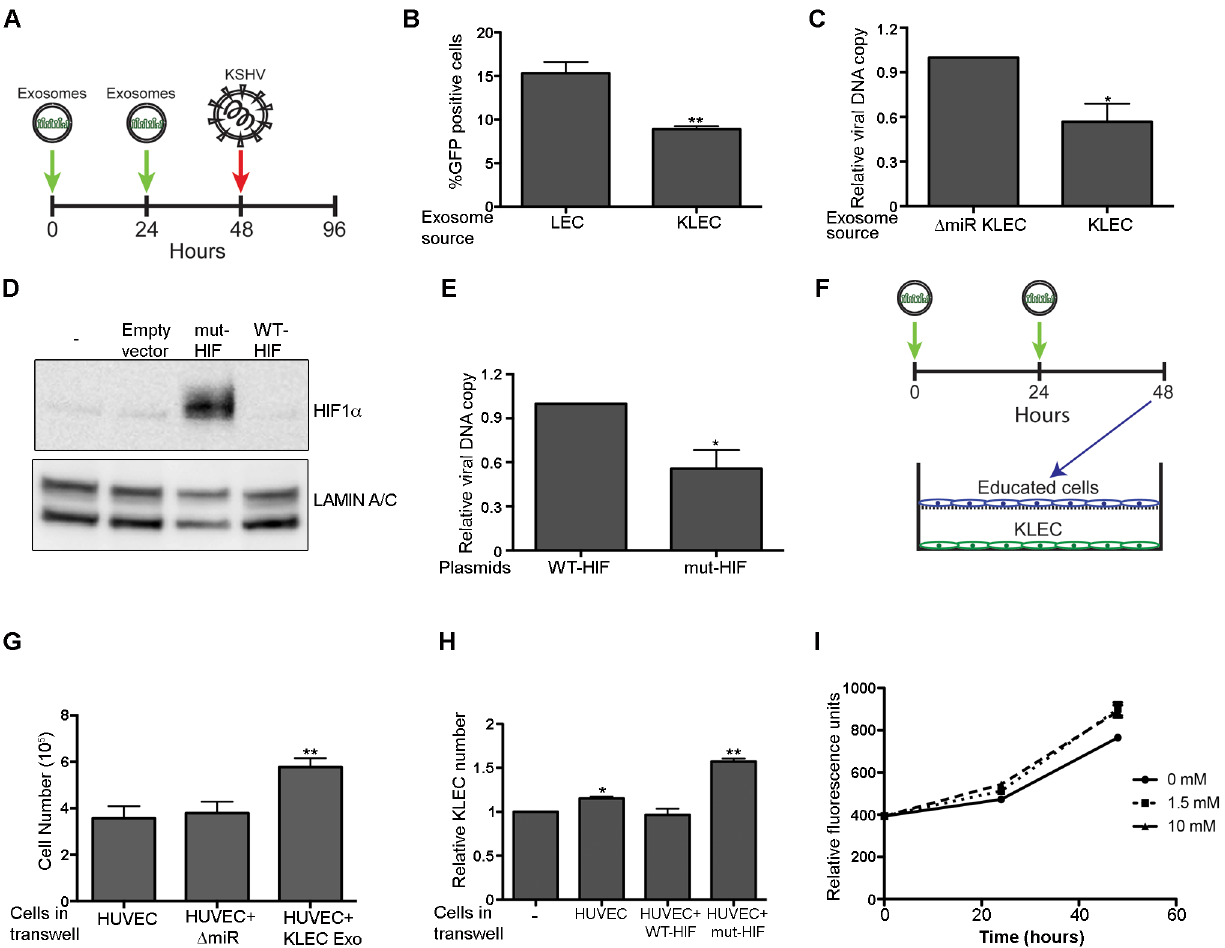
Fig 5. Inducing the reverseWarburg effect inhibits KSHV infection and supports KLEC growth. (A) Schematicillustrationof the procedureused in this study to infect educatedcells. 10 5 non-infected cells were incubatedfor total of 48 hours when 2.5x10 9 exosomes were added every 24 hours, and infected with BAC16-derived WT KSHV. Cells were analysed48 hours’post KSHV infection. (B) Percentage of infected cells after educationusing LEC or KLEC exosomes. Cells were analysedusing flow cytometry. (C) KSHV genome copy numberin LEC educatedusing KLEC and Δ miR-KLEC exosomes, 48 hours post KSHV infection. qPCR was carried out as previouslydescribed[61]. (D) Expression of HIF1 α in LEC expressingthe HIF1 α P402A/P564A mutant. Lysates from cell infected with empty vector (EV), mutant or WT HIF1 α were separated by SDS/PAGE and analysedby immunoblot for expressionof HIF1 α . (E) LEC expressingWT and mut-HIF1 α were infected with BAC16-derived WT KSHV and examinedfor KSHV genomecopy numberusing qPCR. (F) Schematic illustrationof the procedureused in this study to co-culture KLEC with educatedcells. 10 5 HUVEC cells were incubatedfor total of 48 hours when 2.5x10 9 exosomes were added every 24 hours. 10 5 of the educatedcells were washed, trypsinizedand then co-cultured with 10 5 KLEC in Transwell plates for 2 days. (G) KLEC growth in the presenceof educatedHUVEC. KLEC were trypsinisedand each conditionwas countedusing both hemocytometer and the MilliporeScepter 2.0 HandheldAutomated Cell Counter. (H) KLEC growth in the presenceof HUVEC over-expressing HIF1 α . The indicatedcells were co-cultured and counted as describedin (G). (I) KLEC media was supplemented with 1.5 or 10mM sodium L-Lactate. Cell number was measuredusing the CellTiter-Fluor assay (promega)after 24 and 48 hours. All bar graphs present the mean and standard deviationof 3 biologicalrepeats. Statistical significancewas denotedby * P < .05, ** P < .01, *** P < .001.